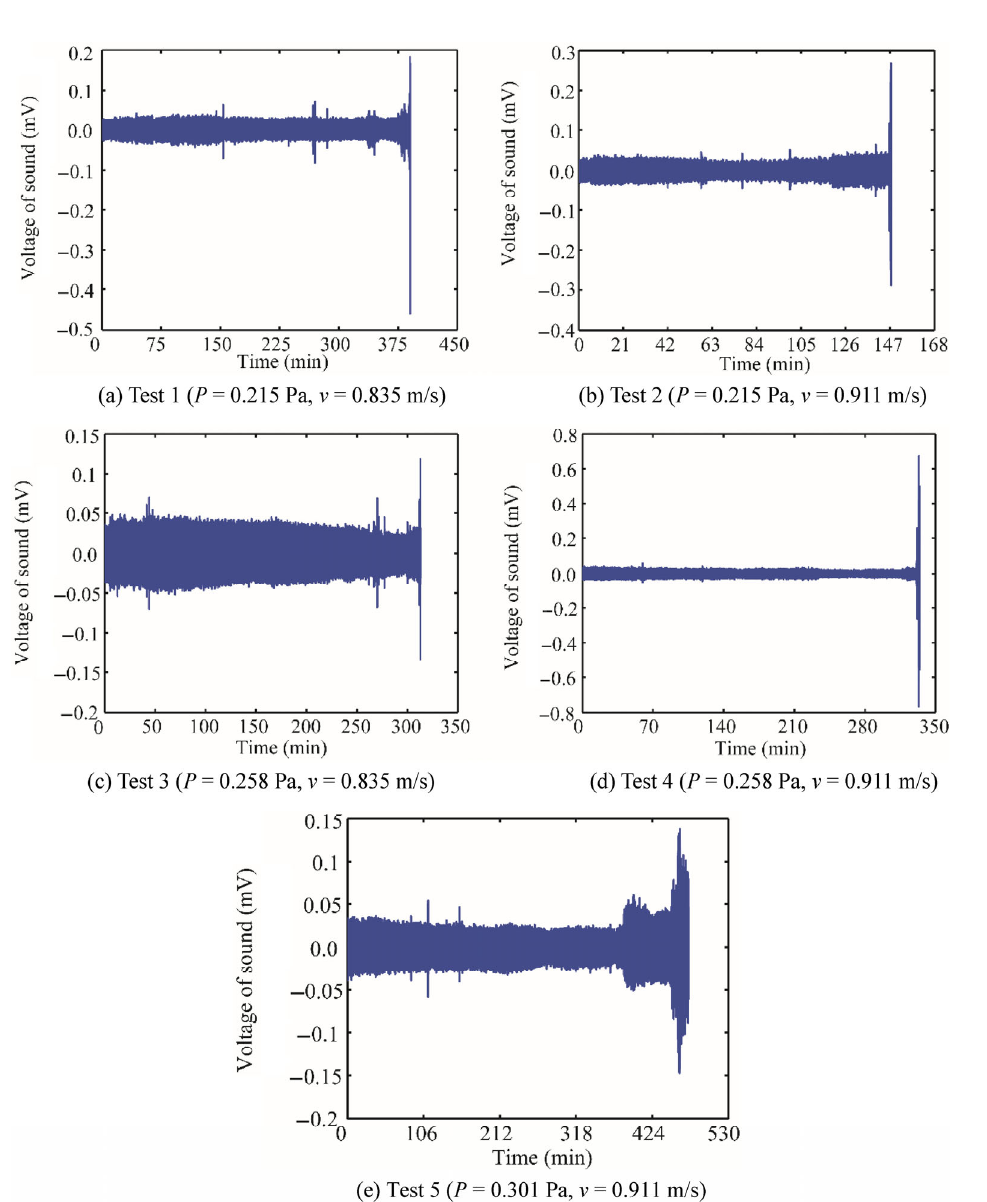
Fig. 3 Friction noise signals in the friction